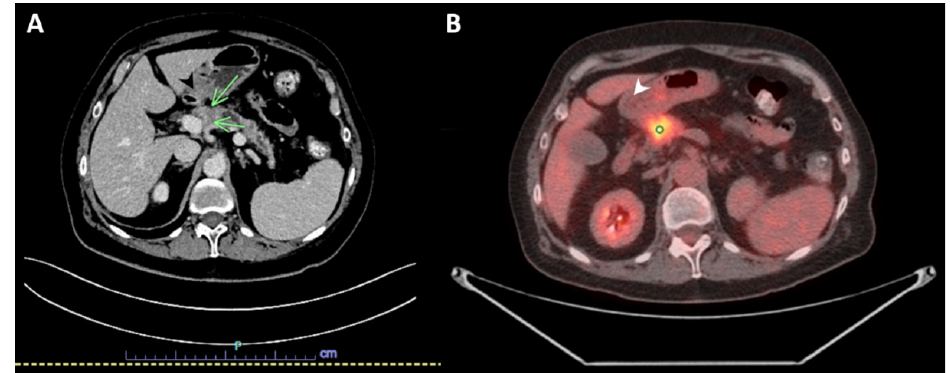
Figure 1. Imaging studies. ( A ) Computed tomography (CT) scan with IV contrast of the